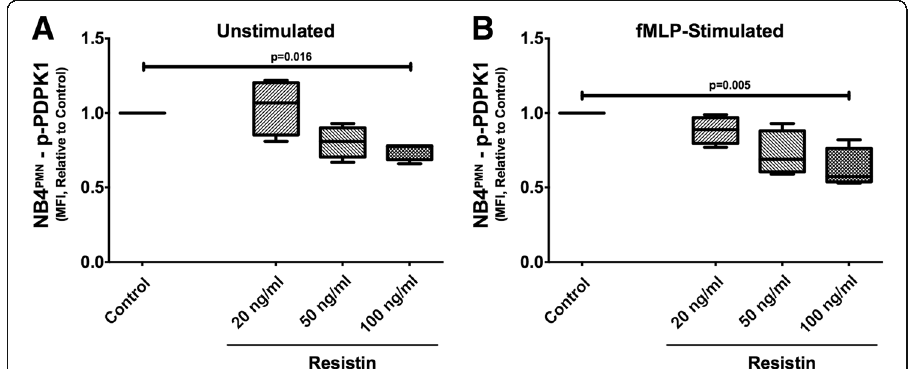
Fig. 3 Resistin impairs PDPK1 phosphorylation in a dose-dependent manner ( a ). This effect appears more pronounced after neutrophil stimulation with fMLP ( b ). N = 4 for all experiments